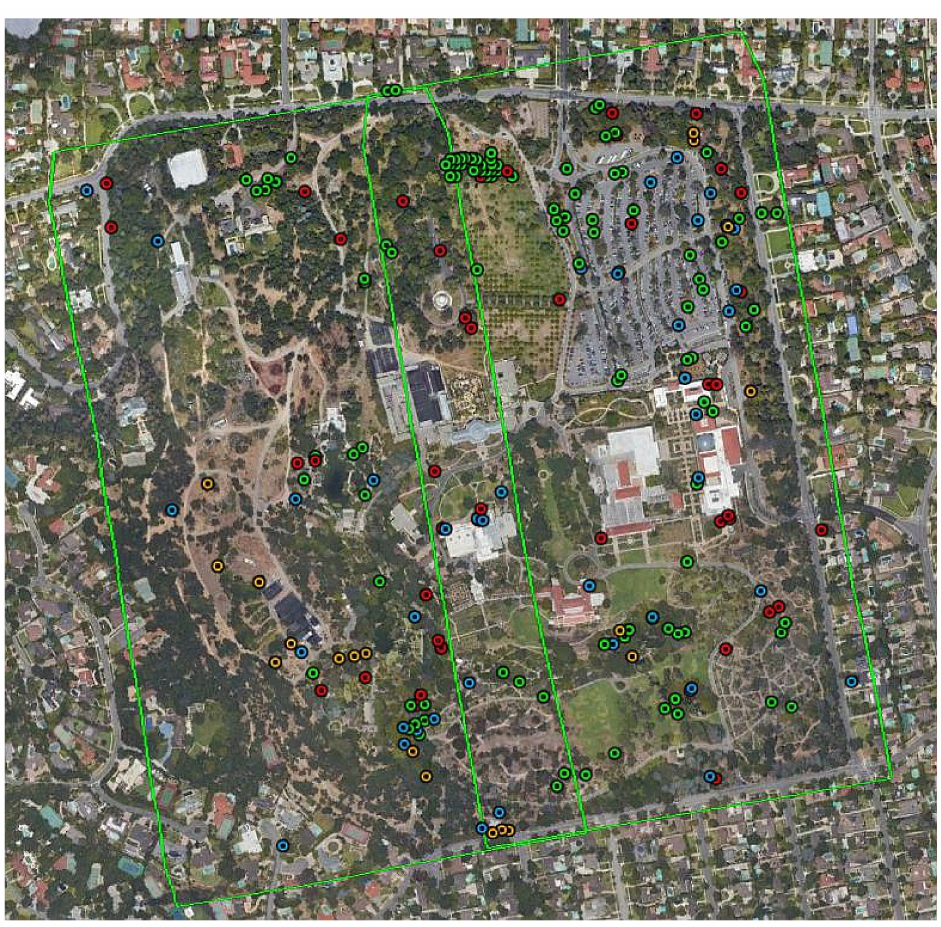
Figure 10. Overview of botanical IDs at the Huntington Botanical Gardens. The green boxes demar- cate the coverage of the two 0.5-m GSD passes flown. Displayed in the Google Earth